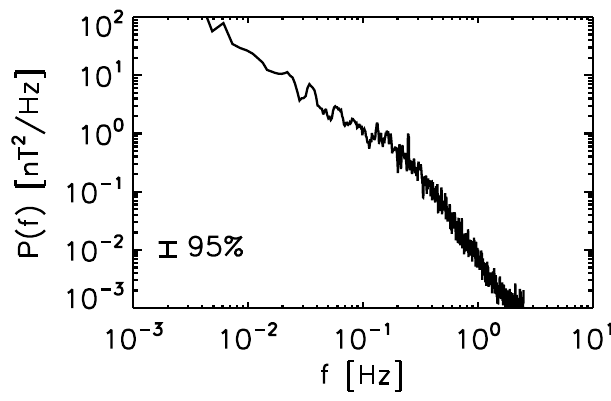
Fig. 8. Frequency spectrum of the magnetic field fluctuation for the time interval shown in Fig.